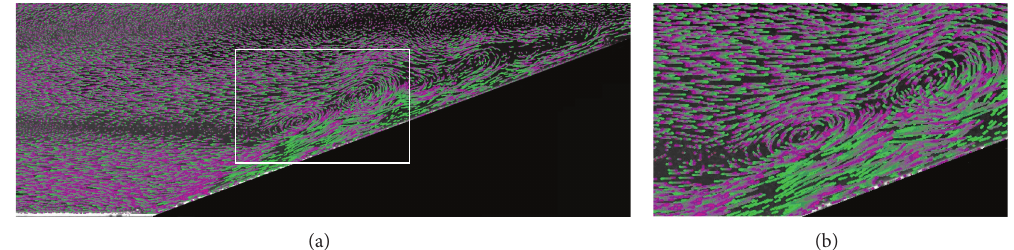
Figure 1: Particle centroids and trajectories reconstructed by HLPT: (a) whole image and (b) zoom in the area highlighted.